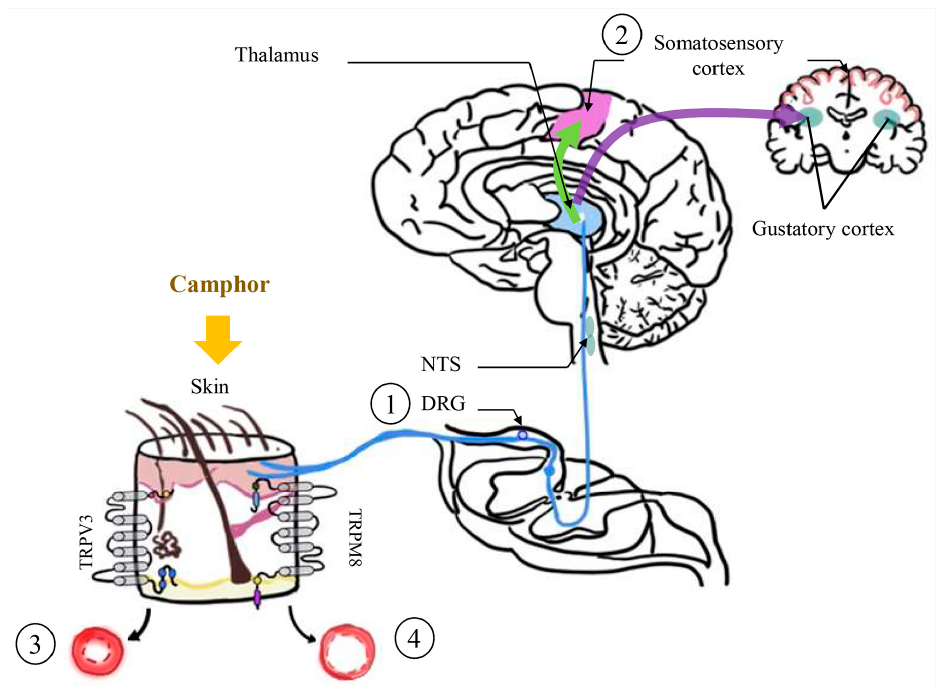
Figure 3. Camphor enhances cold and heat sensation via TRPM8 and TRPV3 and then induces vasoconstriction and vasodilatation (modified from Kotaka et al. 2014 [58]; Selescu et al. 2013 [59]; Steinhoff et al. 2009 [60]). When camphor is applied onto the skin, 1 (cid:13) the stimulus affluxes via the dorsal root ganglion and nucleus tractus solitaries and 2 (cid:13) up to the somatosensory cortex. Once the response to the stimulus is defined in the brain 3 (cid:13) vasoconstriction occurs if the stimulus was associated to cold temperature, otherwise 4 (cid:13) the blood vessels dilate if a hot temperature is sensed. DRG, dorsal root ganglion; NTS, nucleus tractus solitaries; TRPM8, transient receptor potential melastatin 8; TRPV3, transient receptor potential vanilloid 3. The blue line indicates the conduction of the nervous stimuli.